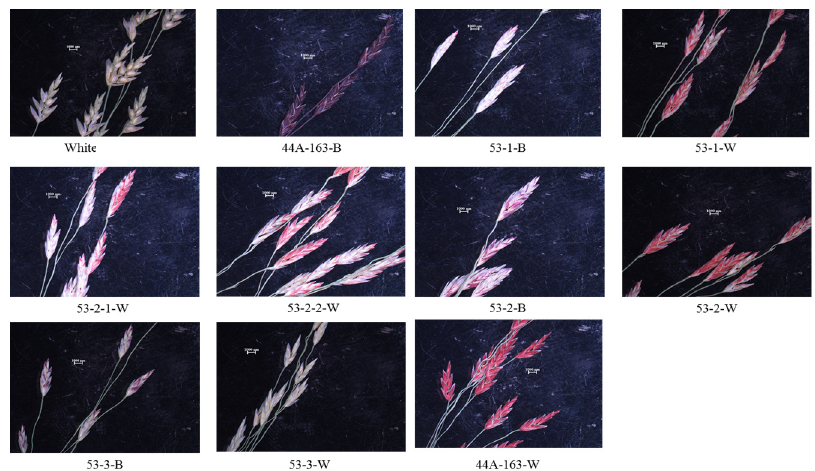
Figure 2. Images of the Spikelets of each of the 11 populations characterized in the field experiment. Table 6. LS means for: AGW (Average Grain Weight), SL (Seed length), SpL (Spikelet length), DSP (Days from Sowing to Panicle emergence), DPM (Days from Panicle emergence to Maturation), and DSM (Days from Sowing to Maturation) for the studied populations and commercial cultivar ’White’’ under the field conditions for the studied populations. Table 7. LS means for sensory traits—appearance (look preference), color (color preference), odor (odor preference), odor intensity (odor strength), texture (softness), acidity (strength), and flavor (taste preference) for the 14 flour samples from the field experiment, as well as 3 market